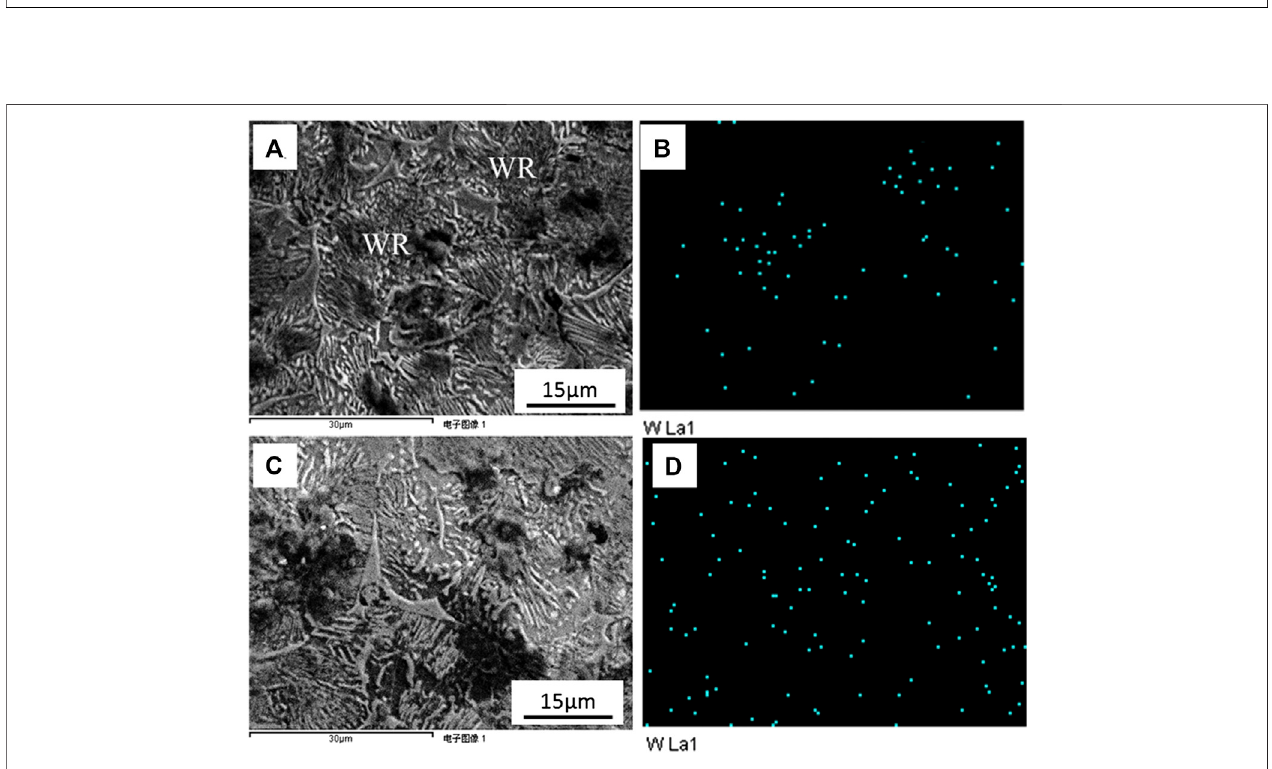
FIGURE 6 | SEM images and EDS results of sintered Fe-2Cu-0.8C-0.6Mo-2W materials from different powder mixtures. (A , B) EL powder mixtures; (C , D) PD powder mixtures